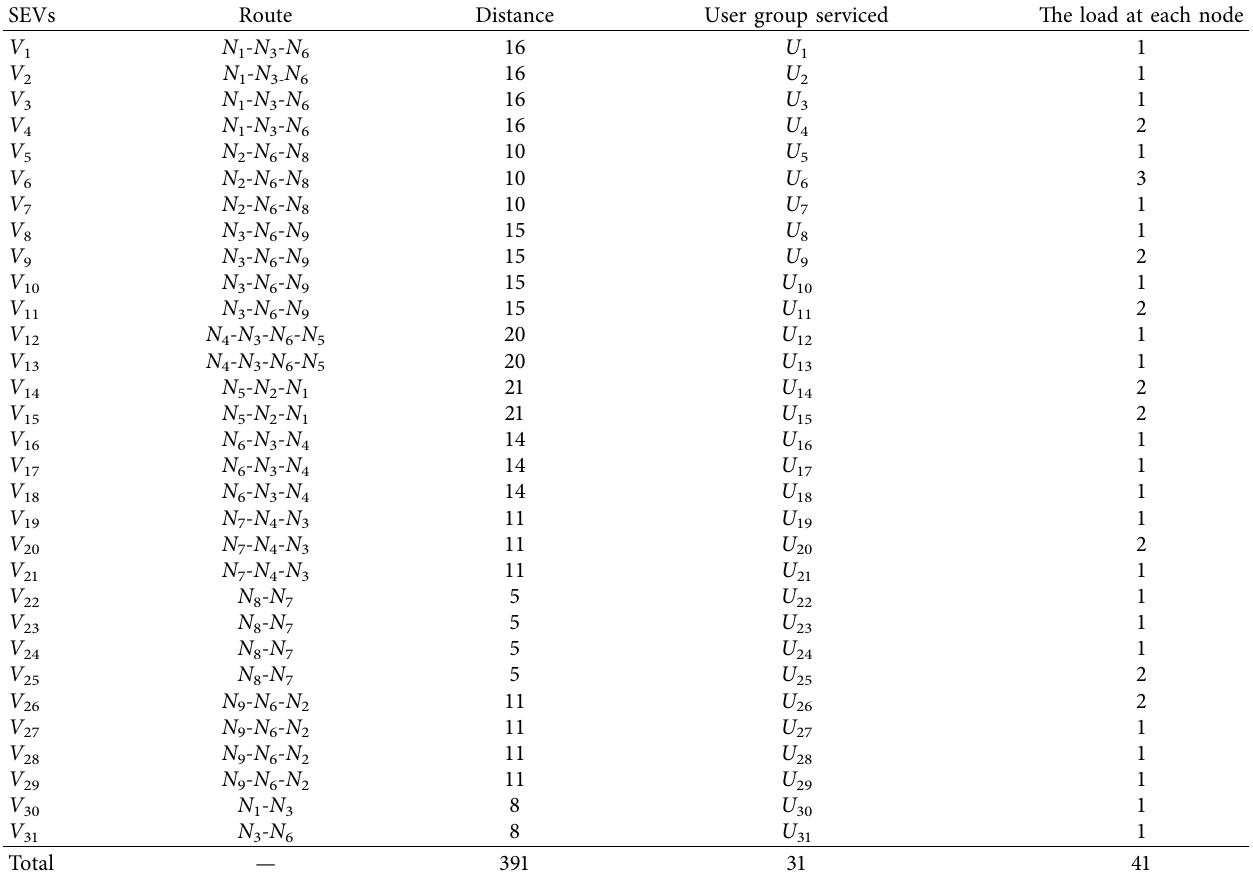
Table 4: SEVs and their routes for the users in